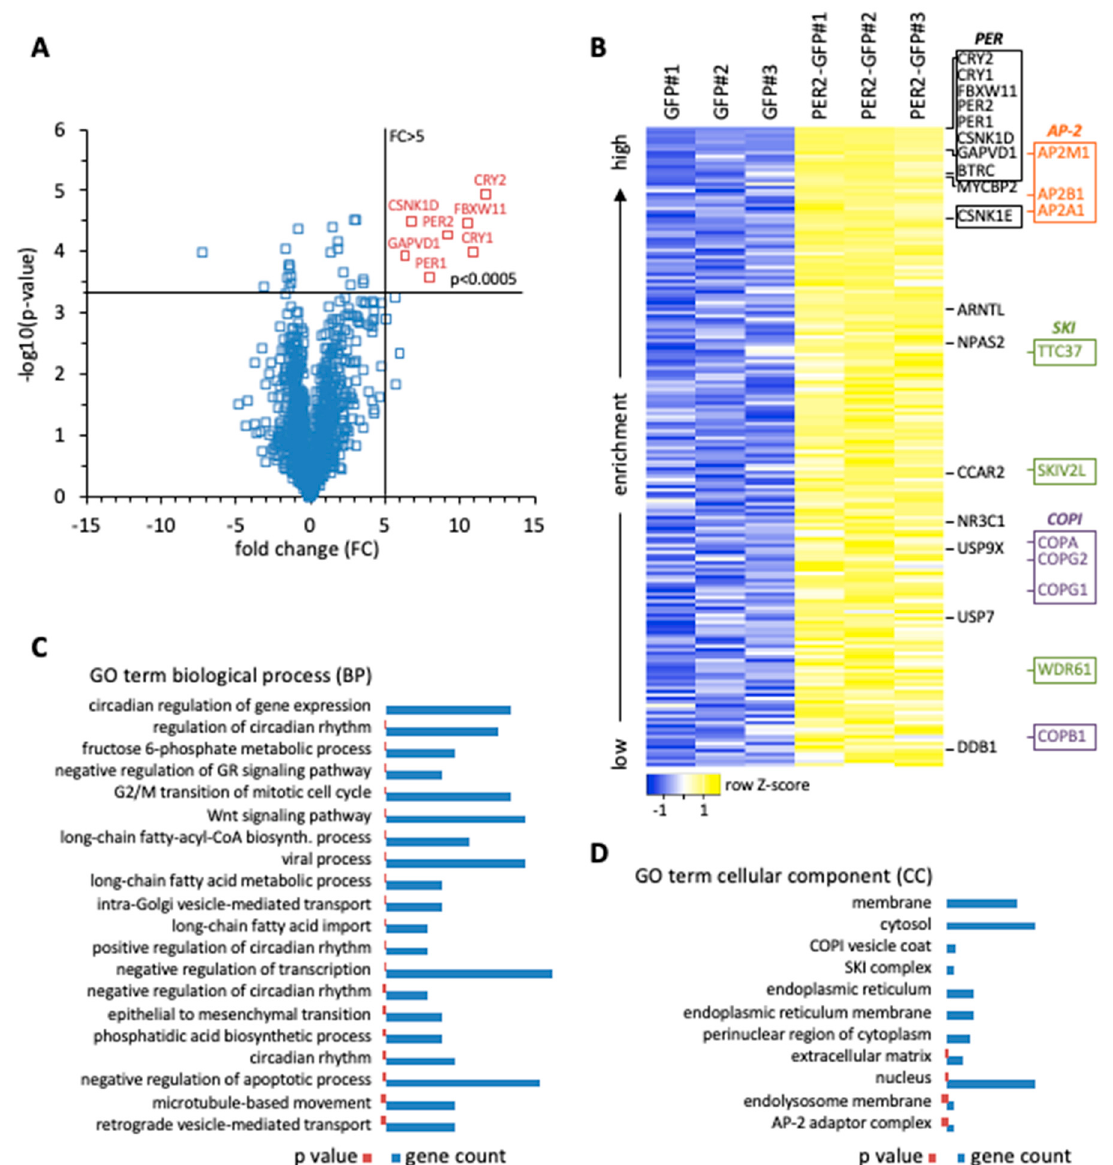
Figure 1. Affinity liquid chromatography–mass spectrometry (LC-MS) and gene ontology (GO) enrichment analyses of Repressor protein period 2 (PER2)-interacting proteins in human HT1080 cells. ( A ) Volcano plot of all proteins identified by affinity LC-MS. Enrichment is plotted as fold change (FC) against -log10( p -value) ( t -test, n = 3). Crosslines delimit proteins with FC > 5 and p < 0.0005 highlighted in red; ( B ) Heat map of significantly enriched PER2-interacting proteins from control (GFP#1–3) and bait (PER2-GFP#1-3) purification replicates (FC > 0, p < 0.05). Colors indicate the distance of a signal from the sample mean in standard deviations (Z-score). Boxes highlight protein complexes. The heat map was created using heatmapper software [18]; ( C , D ) GO analysis of PER2-interacting proteins purged for tubulins, proteasomal, and ribosomal proteins, which are highly abundant in cells and often create an unspecific background in LC-MS experiments. The revised protein list was analyzed with DAVID [19] for the enrichment of GO terms in the categories biological process (BP) ( C ) and cellular component (CC) ( D ). The lists are sorted by increasing p -value shown as red bars (range: BP 1.2 × 10 − 8 − 0.004; CC 1.3 × 10 − 10 − 0.004). The number of genes in each group (gene count) is shown as blue bars (range: BP 3 − 12; CC 3 −